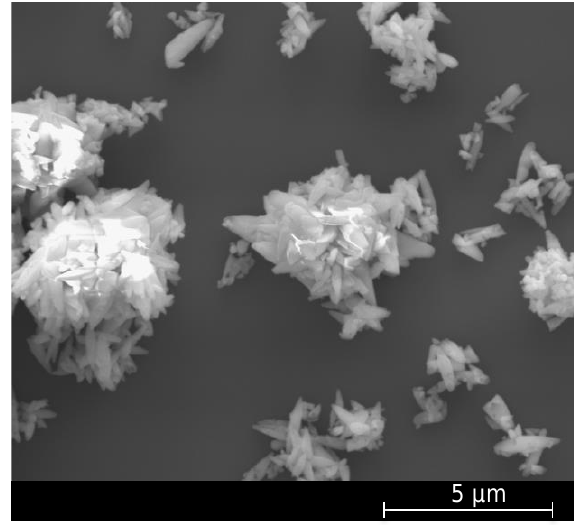
Figure 2. SEM image of the used precipitated calcium carbonate.